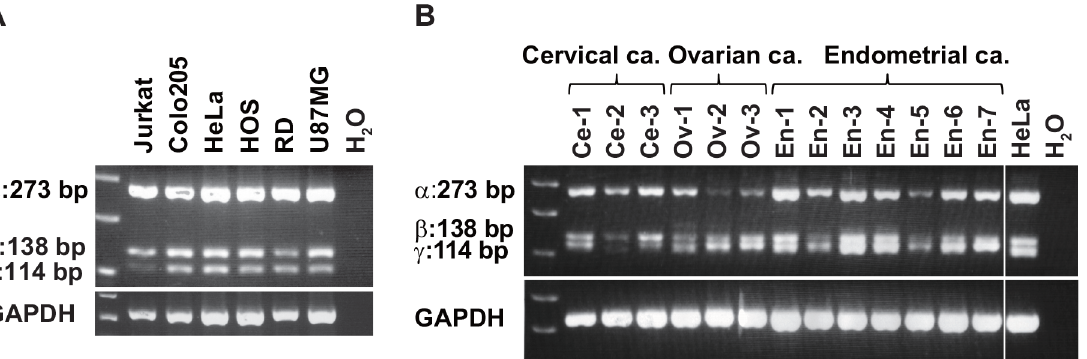
Fig 1. Human cancer cell lines and tissues express sCD155 RNA. PCR was performed using the primer sets located on each side of the different splice sites. Three bands of predicted sizes ( α : 273 bp, β : 138 bp, γ : 114 bp) are observed in PCR products. mRNA for membrane-bound ( α ) and soluble CD155 ( β , γ ) was expressed by various human cancer cell lines ( A ) and cervical, ovarian, and endometrial cancer tissues ( B ).